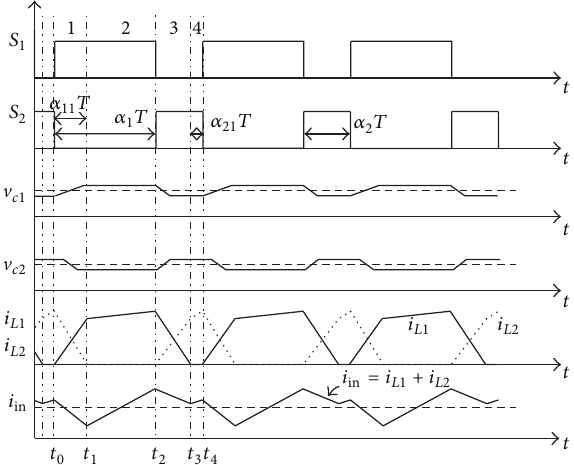
Figure 5: Main waveforms of the new